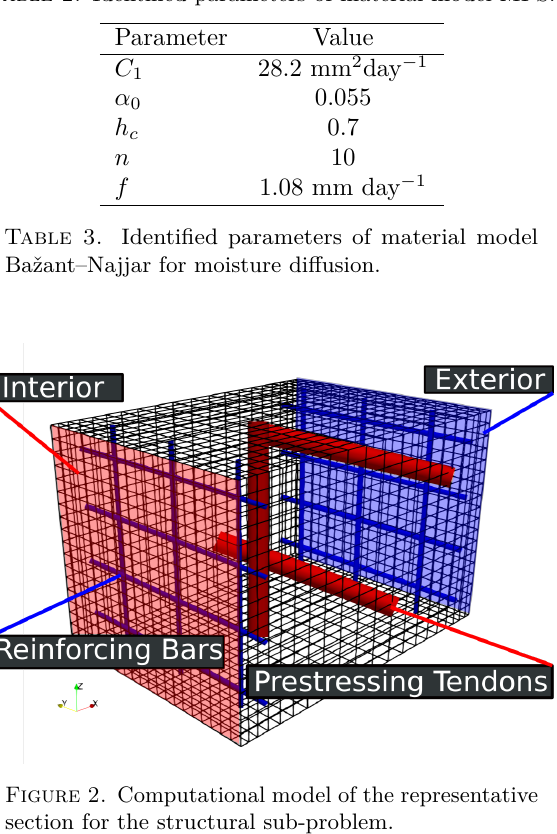
Table 2. Identified parameters of material model MPS.